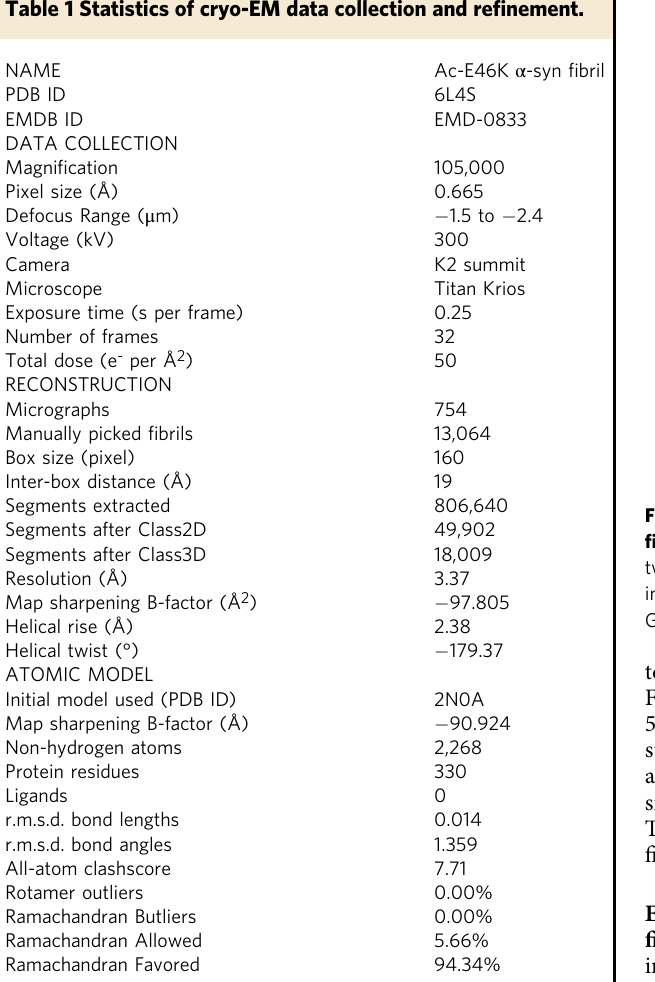
Fig. 1 Comparison of the stability of the Ac-WT and Ac-E46K α -syn fi brils. a Cold denaturation of 20 μ M Ac-WT (blue) and Ac-E46K (red) α -syn fi brils. CD spectra monitored at 0 °C at different incubation time are shown on the left. CD signals at 218 nm are analyzed on the right. b Freeze-thaw denaturation of Ac-WT (blue) and Ac-E46K (red) fi brils. CD spectra obtained at different freeze-thaw cycles are shown on the left. CD signals at 218 nm are analyzed on the right. Data are shown as mean ± s.d., n = 3 biologically independent samples for both panels ( a ) and ( b ). Exact p values of the unpaired, two-tailed Student ’ s t test are shown. c Negative-staining TEM (left) and AFM (right) images of 5 μ M Ac-WT and Ac-E46K α -syn PFFs after sonication. d Size distribution of sonicated Ac-WT and Ac-E46K PFFs. The lengths of the sonicated PFFs are measured by AFM. 300 fi brils were measured for each fi bril sample. e ThT kinetic assay of the Ac-WT and Ac-E46K fi bril formation with or without seeding. Mole percent of added PFF seeds are indicated. Data shown are mean ± s.d., n = 3. f PK digestion of the Ac-WT and Ac-E46K fi brils. The fi brils were incubated with indicated concentrations of PK at 37 °C for 30 min (left). Intensities of the total protein bands of each lane on SDS-PAGE are analyzed on the right. Data shown are mean ± s.d., n = 3 biologically independent samples. Source data are provided as a Source Data fi le.